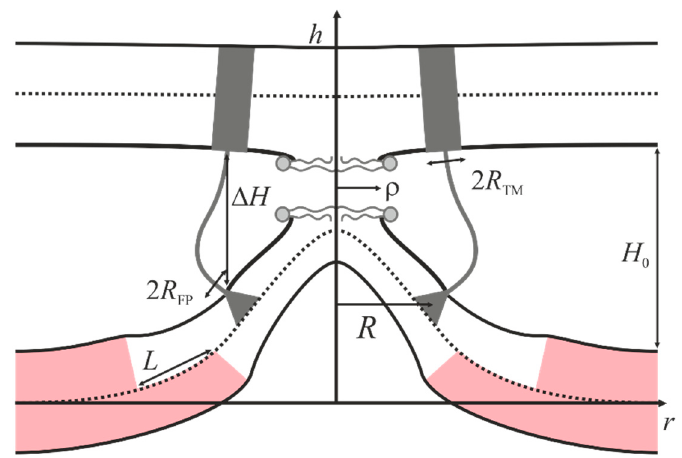
Figure 3. Schematic representation of the model. Distance Δ H between fusion peptides and transmembrane domains of proteins in membranes is used as the reaction coordinate. Transmembrane domains (half-width of R TM ) are schematically shown by gray rectangles, fusion peptides (half-width of R FP ) are shown by gray triangles. H 0 is the equilibrium distance between the membranes, ρ is the radius of the hydrophobic face formed in the area of maximal proximity of the membranes. Raft area is highlighted in pink. The viral membrane is shown on the top, and the cellular membrane is shown at the bottom.